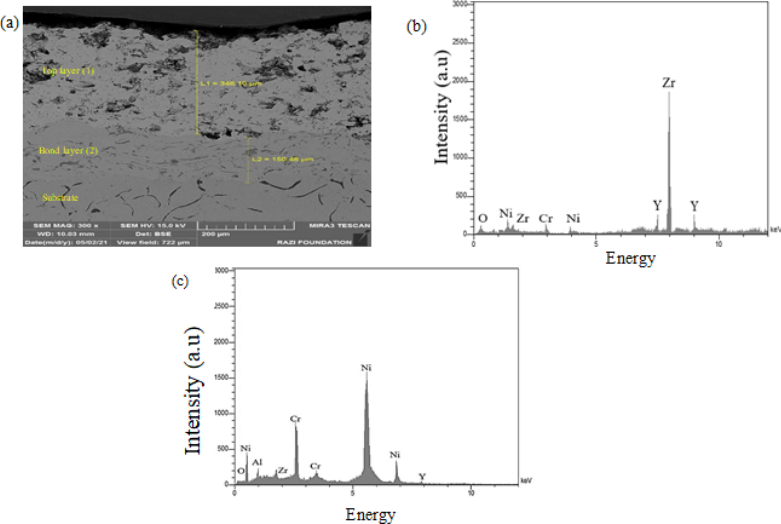
Figure 11: FE-SEM micrographs of (a) polished cross-section of TBC NiCrAlY/nano YSZ (500 µ m) diesel engine cast iron base material, (b) EDS of zone (1) and (c) EDS of zone (2)